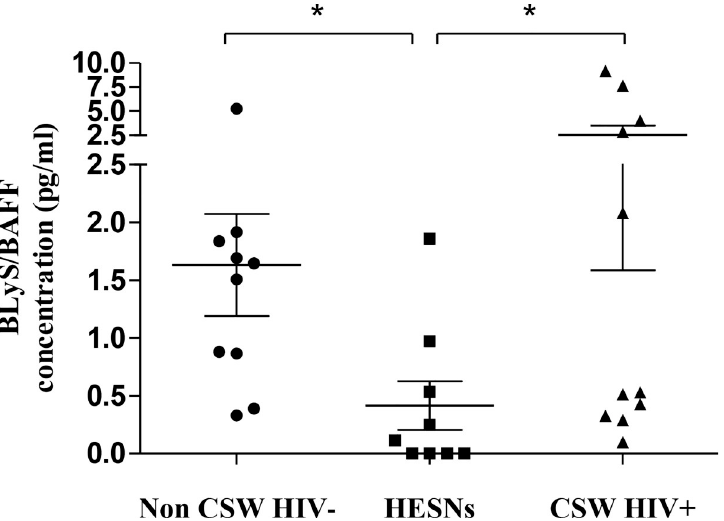
Fig 1. Concentration of BLyS/BAFF in cervicovaginal lavage (CVL) supernatants of HIV-1 uninfected non-CSW, HESN and HIV-1 infected CSW women. Concentrations of BLyS/BAFF (pg/ml) in CVL supernatants were compared with Mann Whitney U test for pair-wise comparisons between HESN and the two other groups. Data are presented as mean ± SD. Significance levels are shown as � (p < 0.05). HIV, human immunodeficiency virus; CSW, commercial sex worker; HESN, HIV Highly-Exposed Seronegative; SD, standard